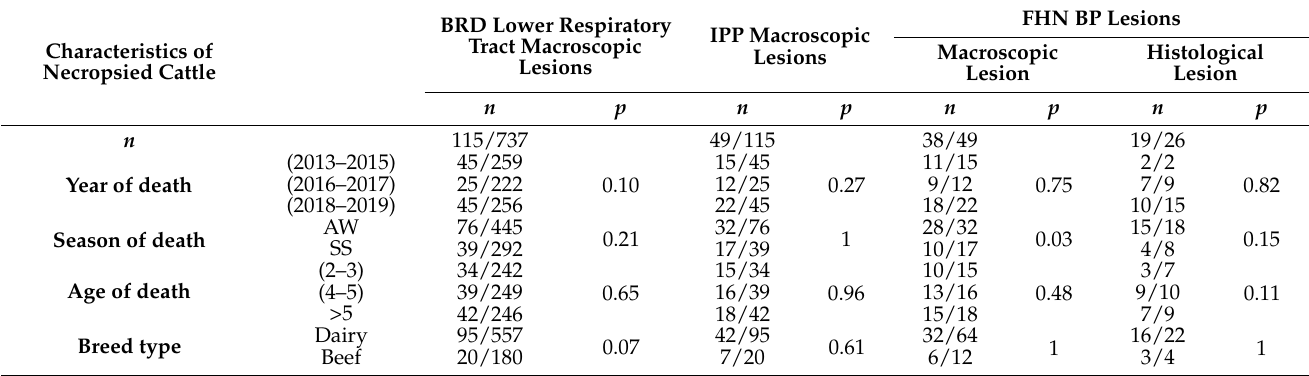
Table 2. Distribution of bovine respiratory disease (BRD) lower respiratory tract lesions; infectious primary pulmonary (IPP) lesions; fibrinous, hemorrhagic and/or necrotic bronchopneumonia (FHN BP) lesions in 737 adult cattle, according to years of necropsy, season, age and breed type (AW: Autumn/Winter, SS: Spring/Summer).